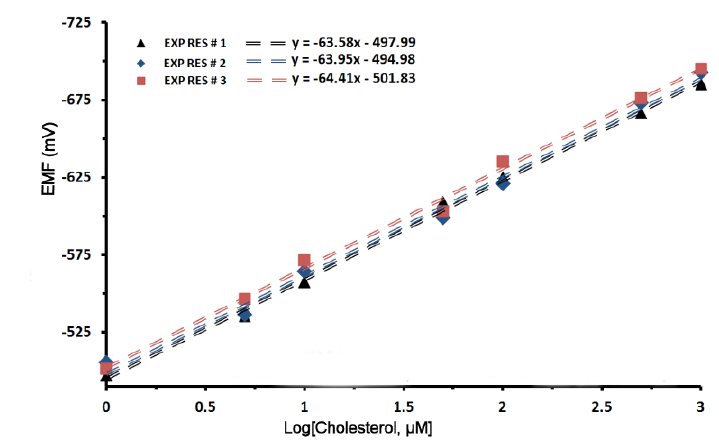
Figure 6. Repeated experimental calibration curves utilizing single